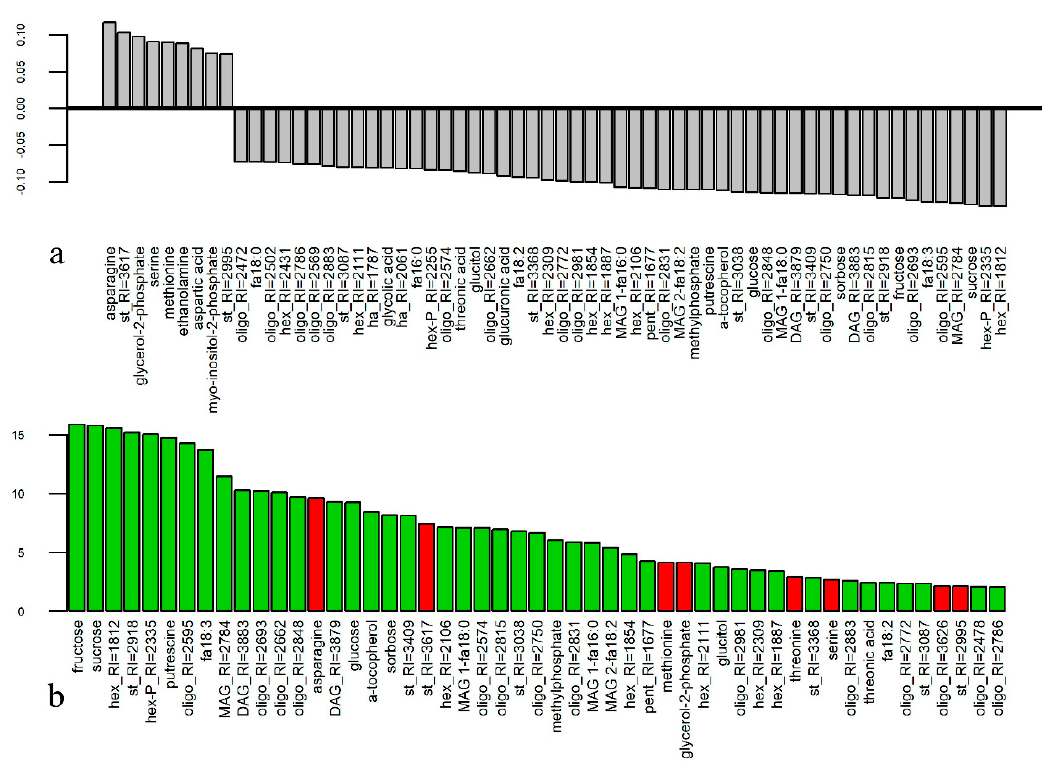
Figure 2. Features selection related to male sterility/fertility. ( a ) Loadings of a predictive component with VIP (variable importance in projection) values greater than 1. Positive values characterize metabolites with higher content in anthers of sterile genotypes; ( b ) Mean decrease accuracy (MDA) values obtained with the Random Forest (RF) method of classification. Green–higher in fertile, red–higher in sterile genotypes.